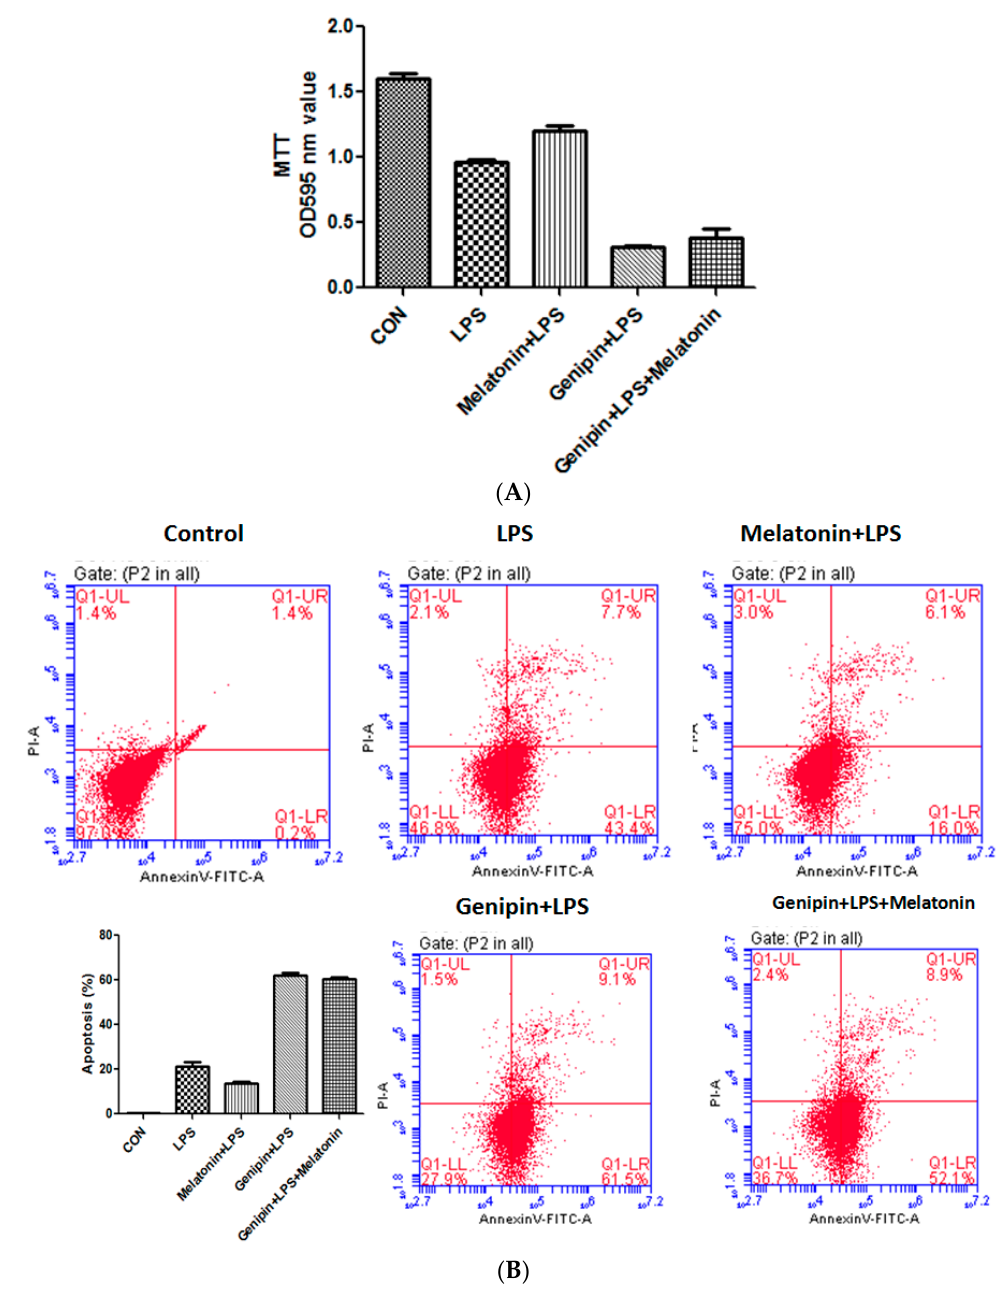
Figure 7. Effect on cell viability and apoptosis in the cultured AC16 cells. Panel ( A ): Effect on cell viability assessed by MTT assay. Vertical axis: OD value; horizontal axis: treatment. Panel ( B ): Effect on apoptosis assessed by annexin-V assay.